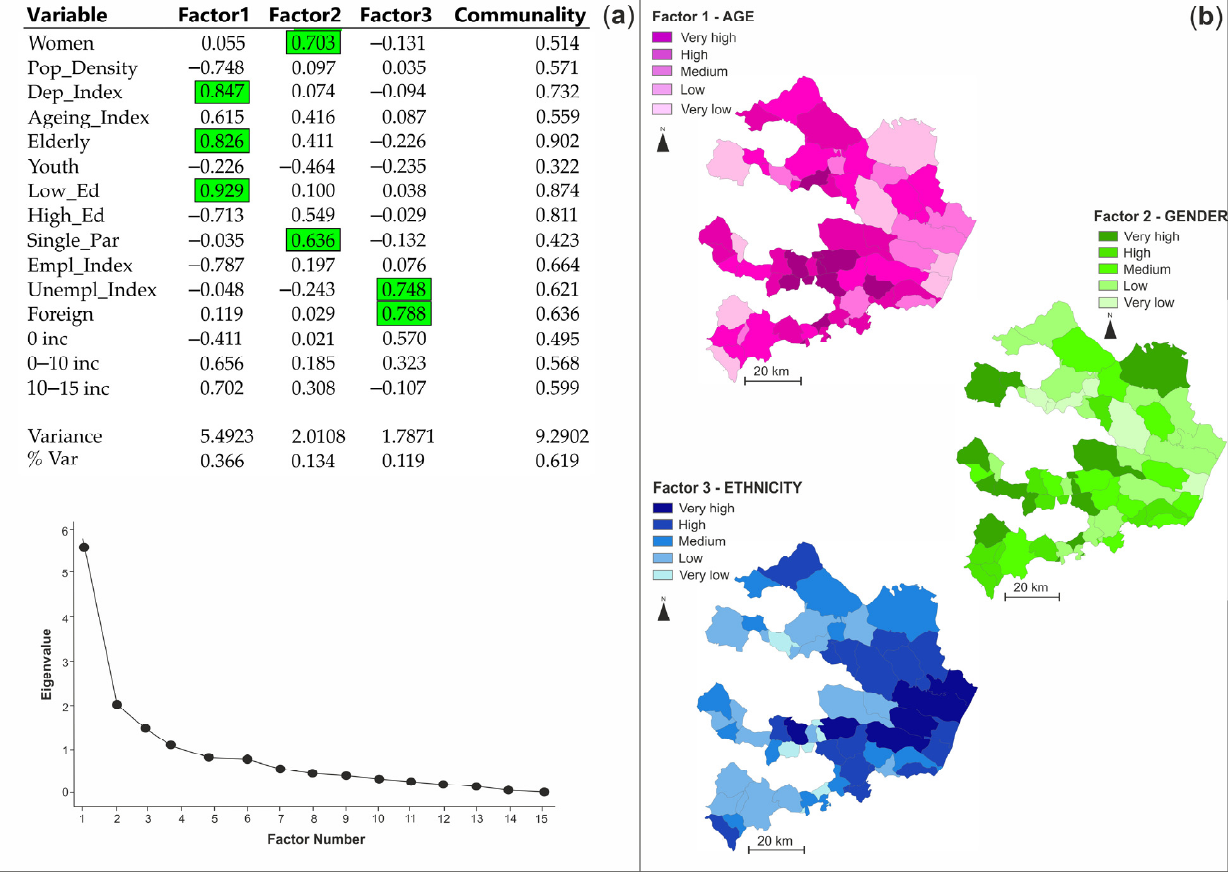
Figure 6. Outcomes of the factor analysis with varimax rotation. ( a ) Loadings and communalities showing the factor correlations (green color) and, on the bottom, the Scree Plot of the variables with their eigenvalues; Pop_Density = population density, Dep_Index= Dependency index; Low_Ed = low education; High_Ed = High Education, Single_Par = Single Parents, Empl_Index = Employment Index, Unemp_Index = Unemployment Index; 0 inc = 0 income; 0 – 10 = income between 0 and 10,000 euros; 10 – 15 inc = income between 10,000 – 15,000 euros. ( b ) Spatial distribution of the main social-economic factors representing the entire dataset.